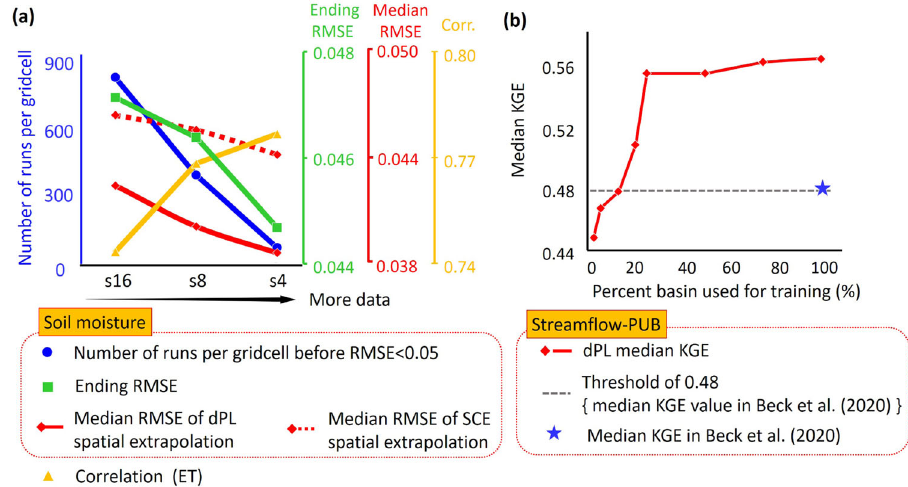
Fig. 7 Scaling curves of dPL. a Training data sampling density increases from s16 to s4. Dashed and solid red curves share the same red y axis (dashed line is for SCE-UA, to enable comparison). b Scaling curve for the spatial extrapolation (PUB) test with the Beck20 global headwater catchment